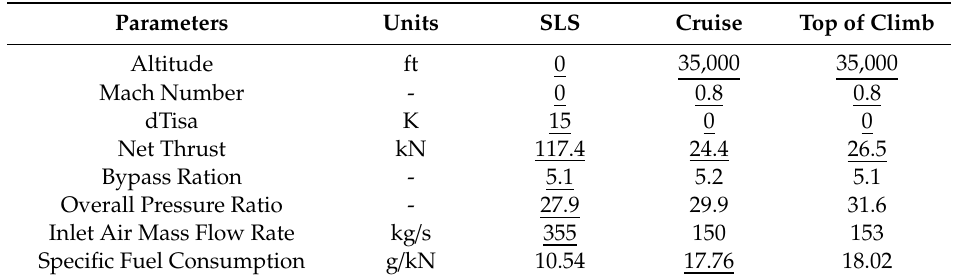
Table 4. CFM56-7B26 Turbomatch model.